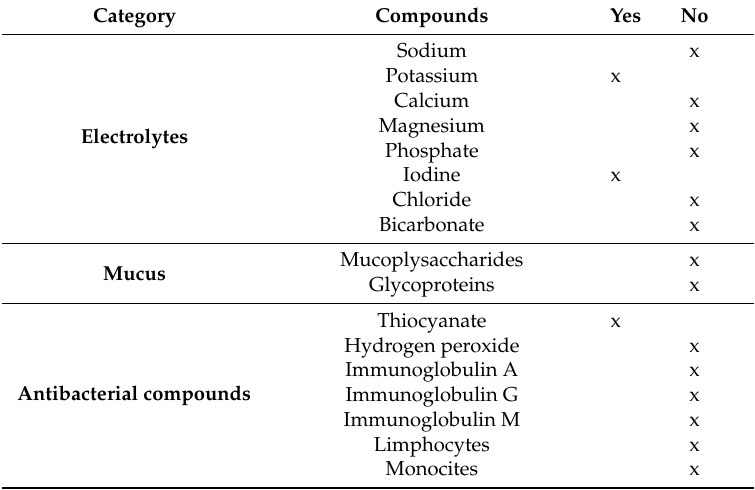
Table 3. The main salivary constituents and the biosensors developed for their